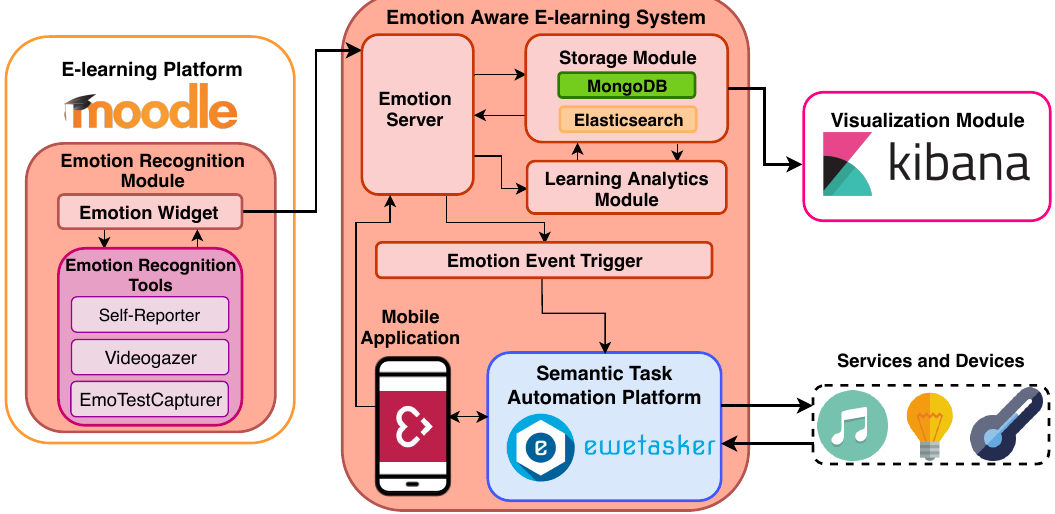
Figure 1. Emotion-aware e-learning platform